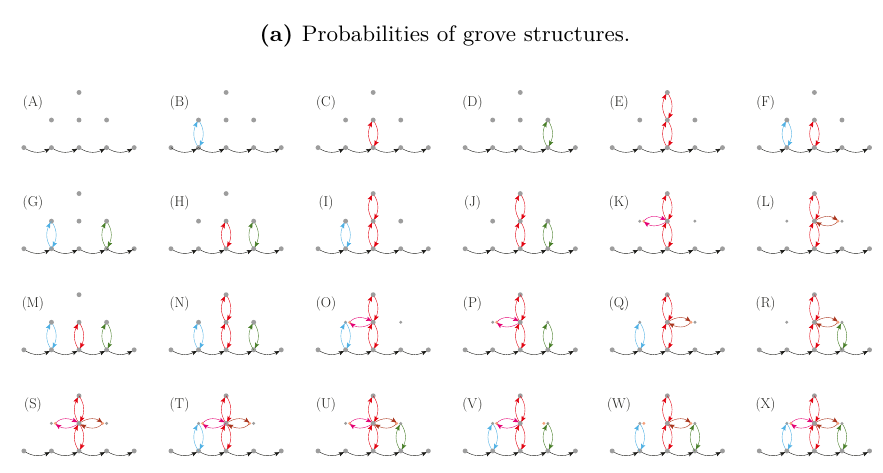
Figure 4. Generation of primitive grove structures for E CM = 91 . 2 GeV from the 32-qubit ibmq_qasm_simulator and the 27-qubit ibm_algiers device, compared to the analytically calcu- lated classical